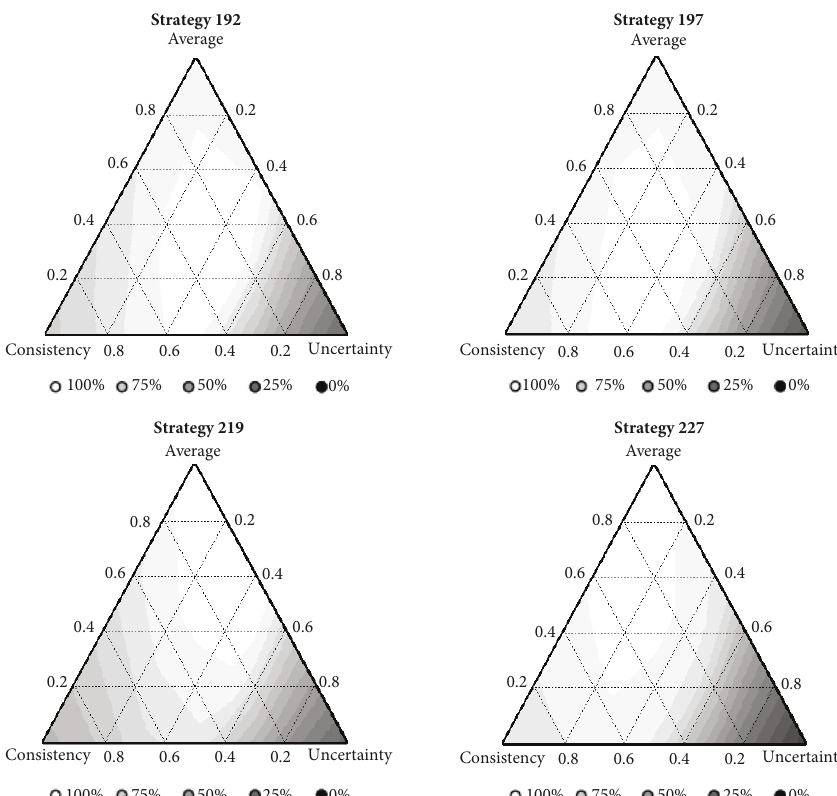
Figure 13: Synthesized efficiency plots for the four promising solutions. The white-gray-black coloring scale shows high to low synthesized efficiency, which measures the relative performance of a strategies relative to the best possible for any given